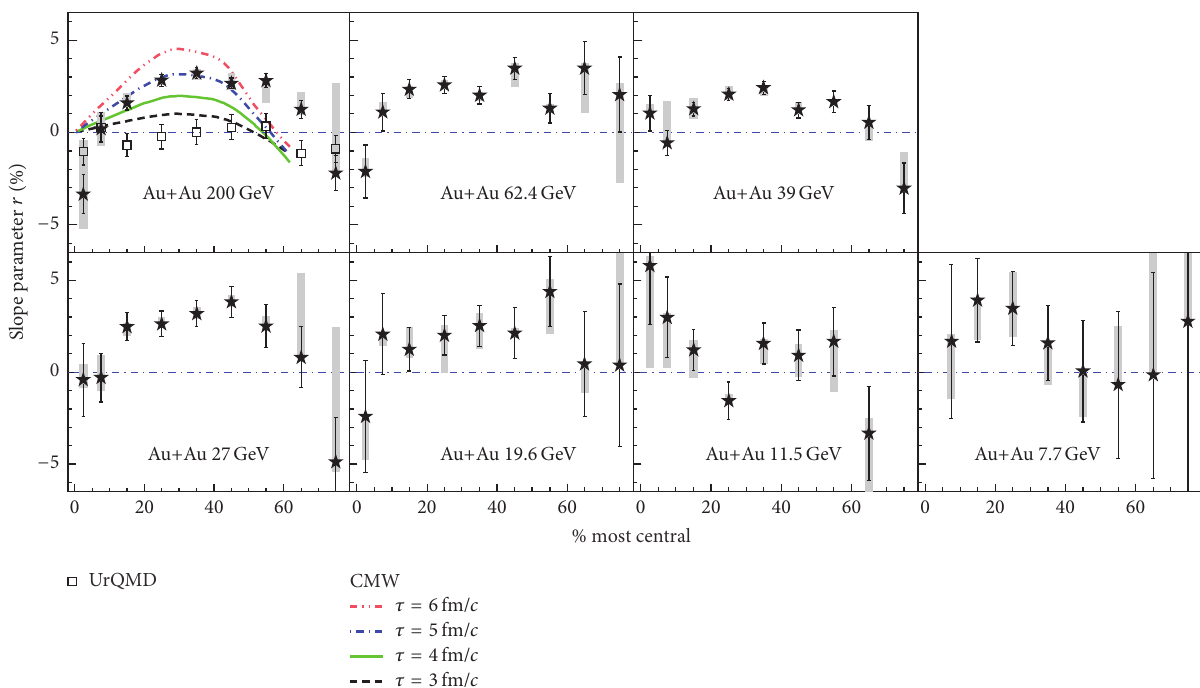
Figure 15: The slope parameter 𝑟 as a function of centrality for Au+Au collisions at 7.7–200 GeV [80]. The gray bands represent the systematic errors. For comparison, we also show the UrQMD calculations [60] and the calculations of the CMW [81] with different duration